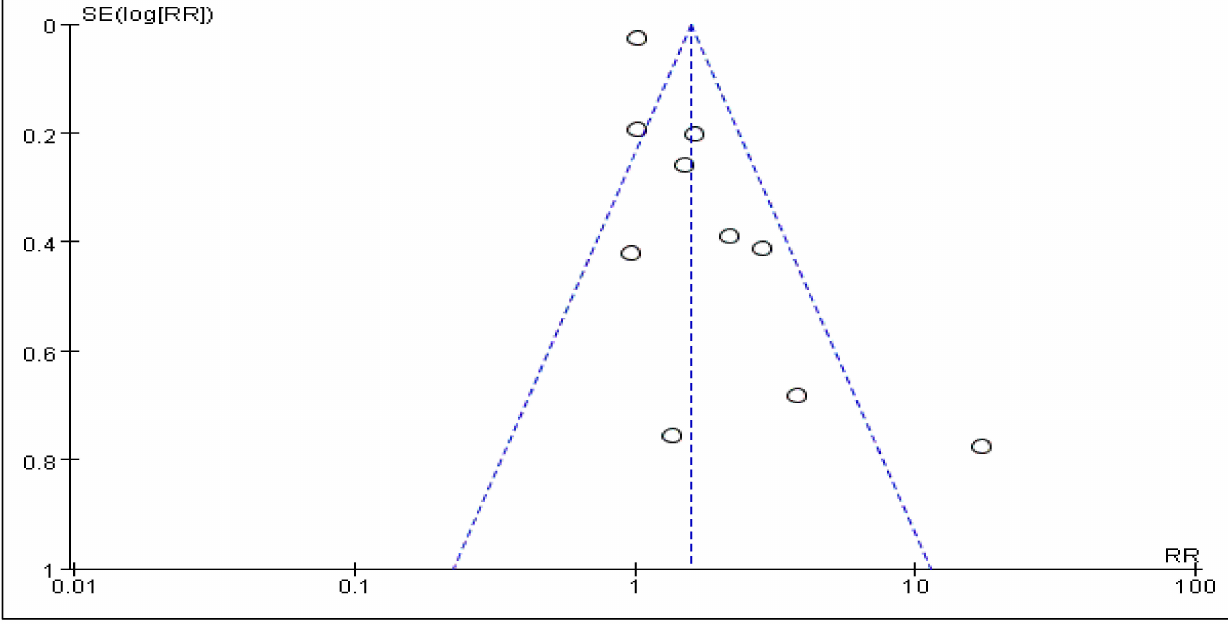
Figure 7. Funnel plot for publication bias